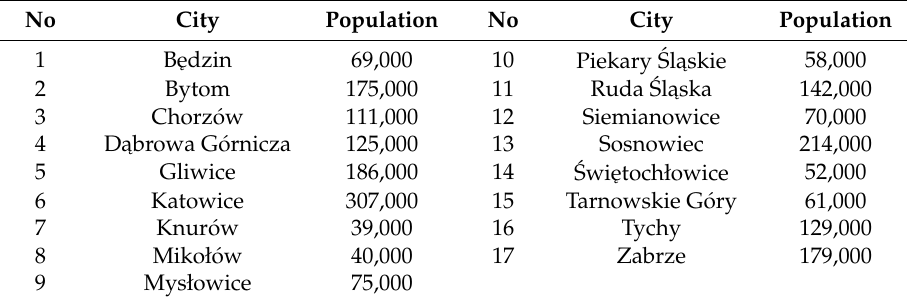
Table 2. Selected metro networks in the world. City